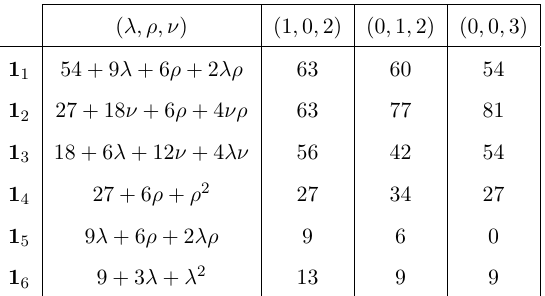
Table 10 . Hypermultiplet multiplicities for the charged matter in the three explicit charge 6